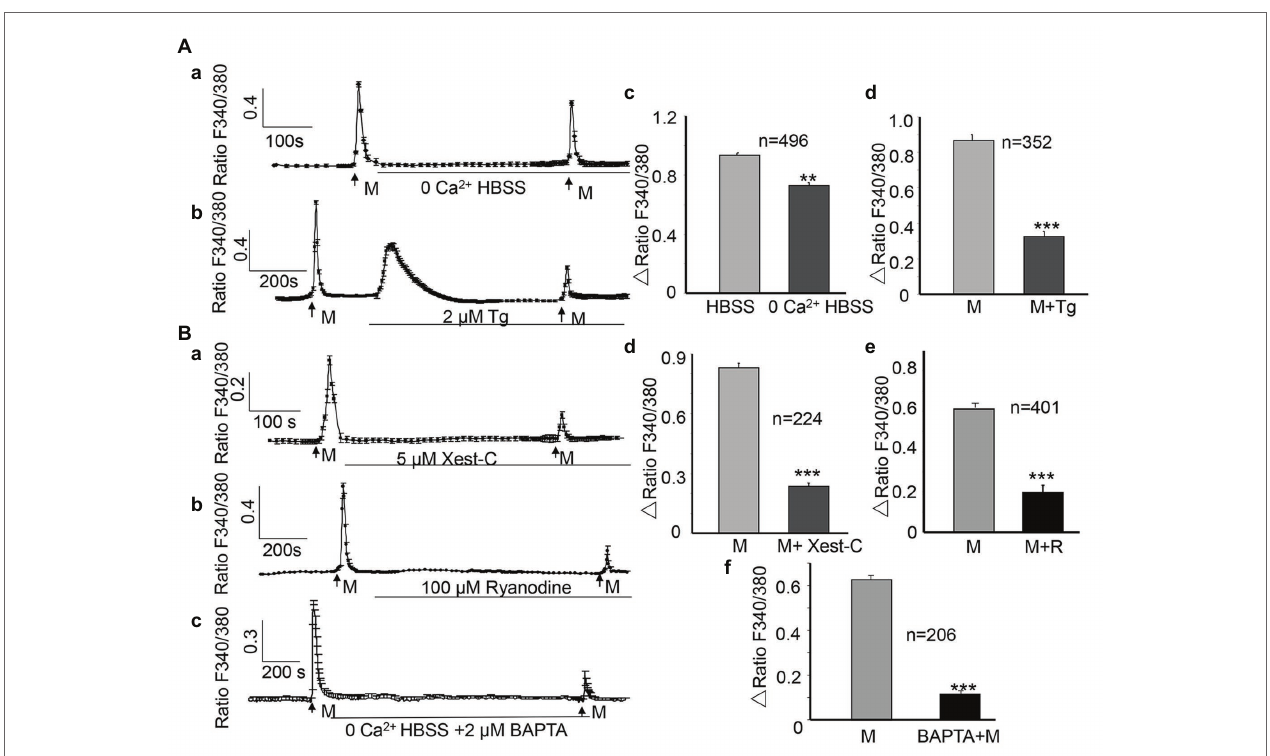
FIGURE 4 | Both Ca 2+ influx and Ca 2+ release from intracellular stores contribute to the ALI-induced [Ca 2+ ] i increases. (Aa,Ab) Typical traces showing switching from normal HBSS to 0 Ca 2+ HBSS (Aa) or depletion of intracellular Ca 2+ stores with thapsigargin ( Ab , Tg, 2 μ M) reduced the ALI-evoked [Ca 2+ ] i increase. Note that thapsigargin alone induced a sustained increase of [Ca 2+ ] i . (Ac,Ad) Summary data for 0 Ca 2+ HBSS ( Ac , n = 496 cells, p < 0.01); and thapsigargin ( Ad , n = 352 cells, p < 0.001). (Ba–Bc) Typical tracings showing that Xest-C (5 μ M), the IP3 receptor-specific antagonist (Ba) , ryanodine (100 μ M), the ryanodine receptor antagonist (Bb) , and BAPTA-AM (2 μ M, Bc ) reduced the ALI-induced [Ca 2+ ] i increase. (Bd–Bf) Summary data for Xest-C ( Bd , n = 224 cells, p < 0.001), ryanodine ( Be , n = 401 cells, p < 0.01), and BAPTA-AM ( Bf , n = 206 cells, p <